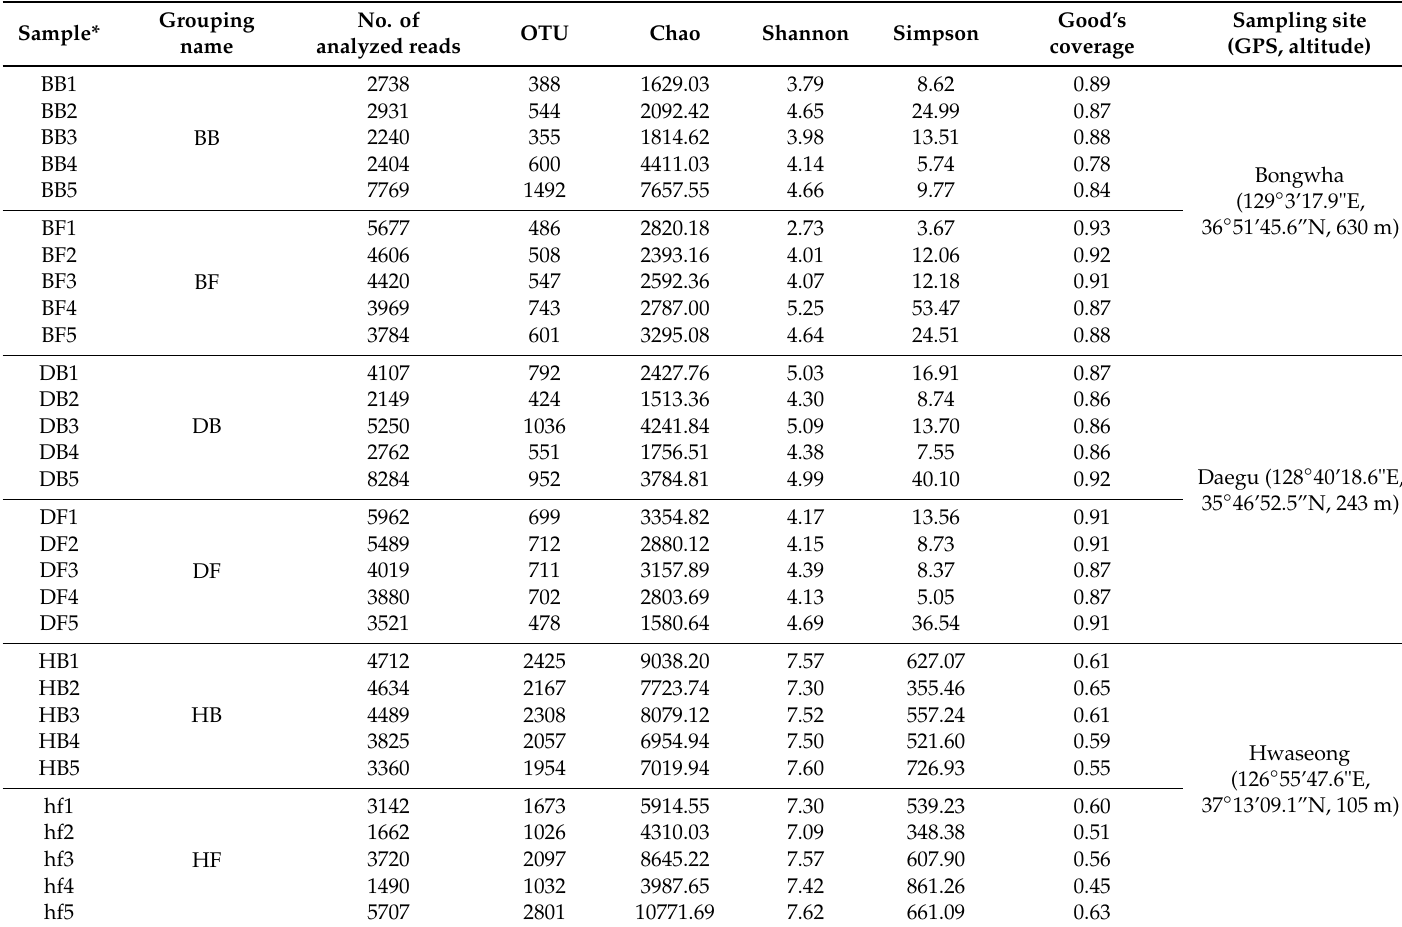
Table 1. An overview of the soil samples and estimates of 16S rRNA gene sequence diversity and phylotype coverage of the PacBio data. Diversity was estimated using operational taxonomic units (OTUs). Diversity indices and richness estimators were calculated using the Mothur package (the mother project; http: //